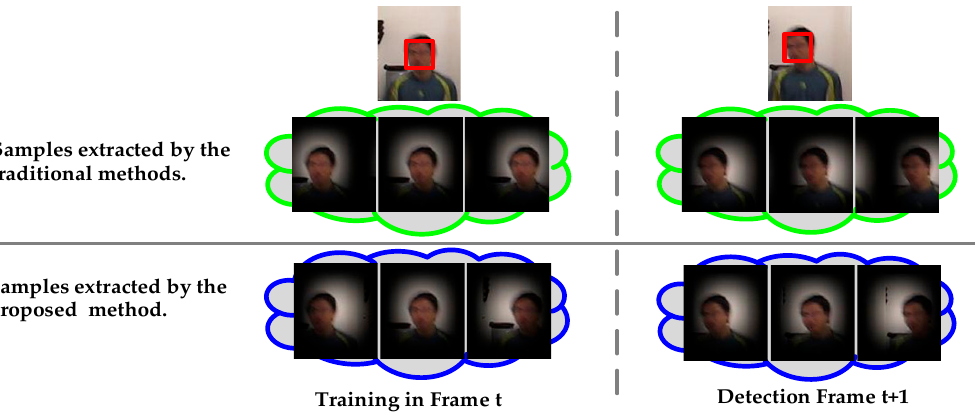
Figure 1. Sampling strategies of traditional correlation filter-based methods and the proposed method. The boy in the figure is blurry due to fast motion. Two input images where the red box area is the target ( Top row ). Weights and image content execute synchronously cyclic shifts ( Middle row ). Weights are independent and do not execute cyclic shifts with image content ( Bottom row ).